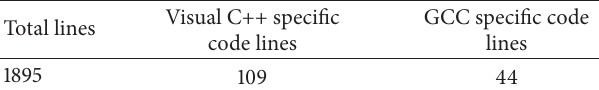
Table 1: Interception library compiler dependant